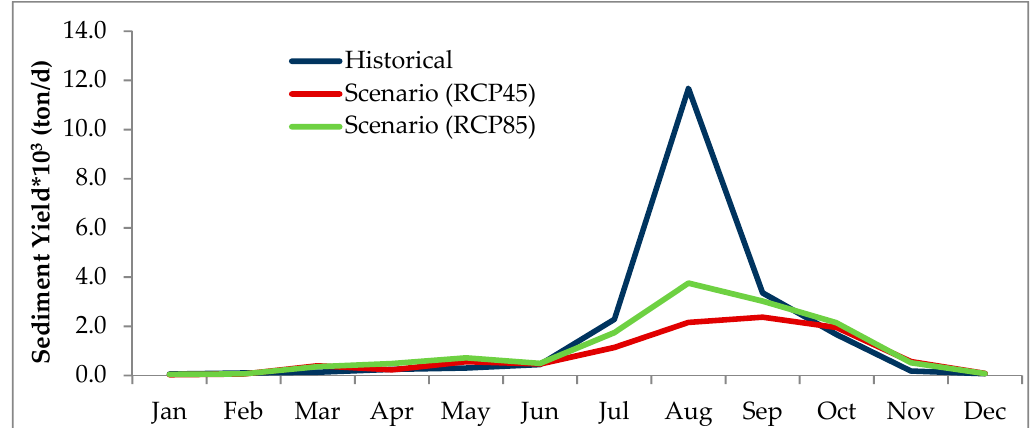
Figure 8. Sediment yield in the Meki River in the future scenario as compared to the historical period (1985–2010).